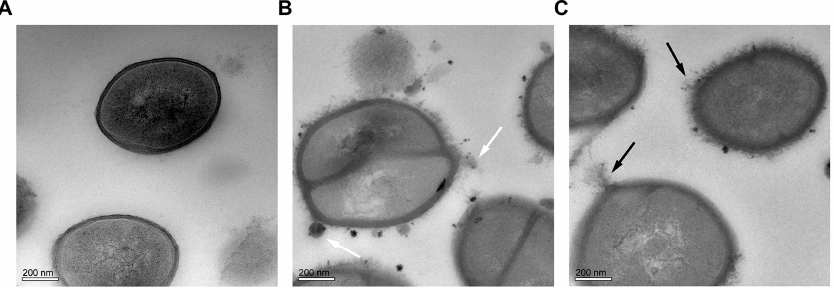
Figure 6. Transmission electron microscopy images of S. aureus ATCC 6538. ( A ) untreated bacteria; ( B ) and ( C ) bacteria treated with CHQA at 2 × MIC for 6 h.